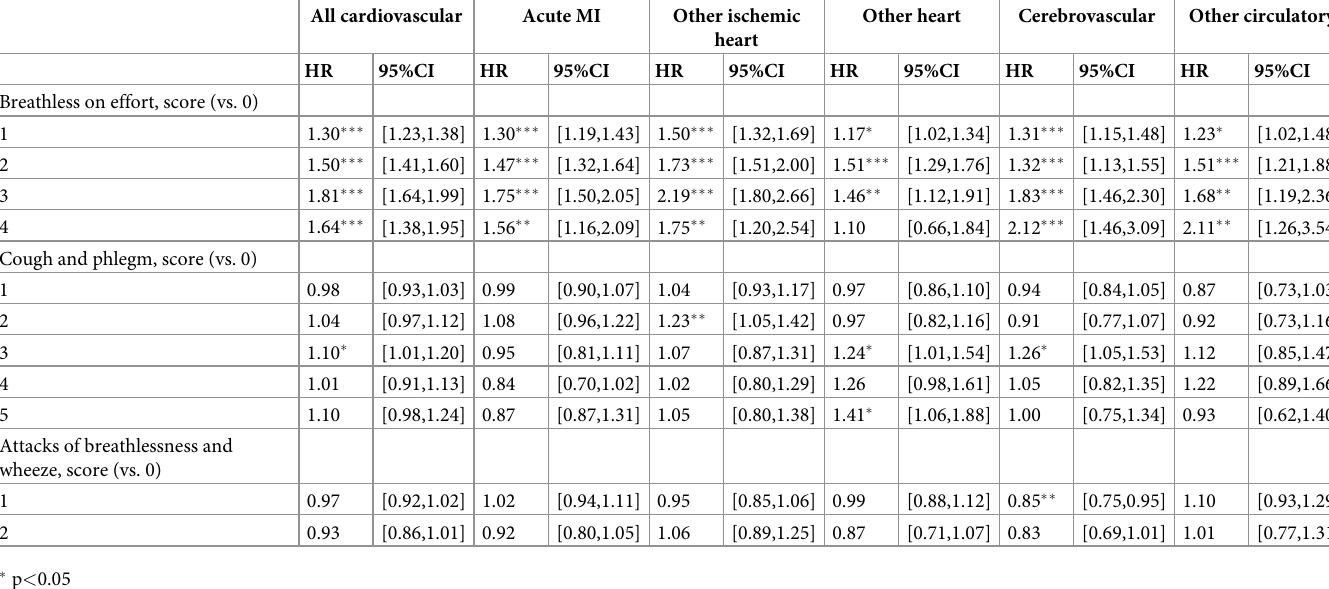
Table 4. Hazard ratios with 95% confidence intervals and p-values according to cause of death, multivariable proportional hazards regression analysis with adjust- ment for sex, education, smoking status, occupational exposure to gas/dust, previous angina pectoris, previous other heart disease and previous myocardial infarc- tion, and birth cohort (n =